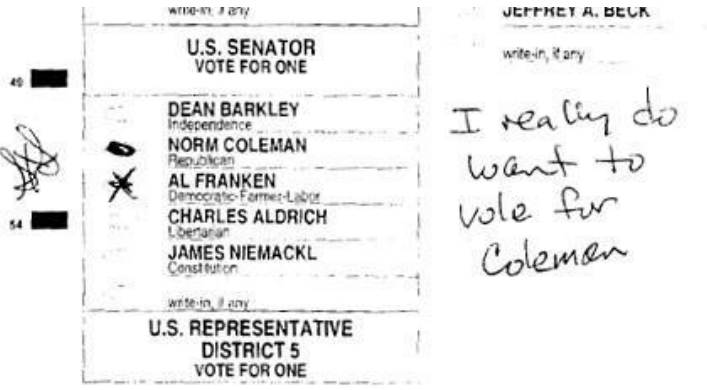
Figure 1: Both campaigns challenged this Hennepin County ballot with the Coleman campaign saying the voter’s intent is clear and the Franken campaign saying what appears to be initials constitute an identifying mark on the ballot (Tibbetts & Mullis,